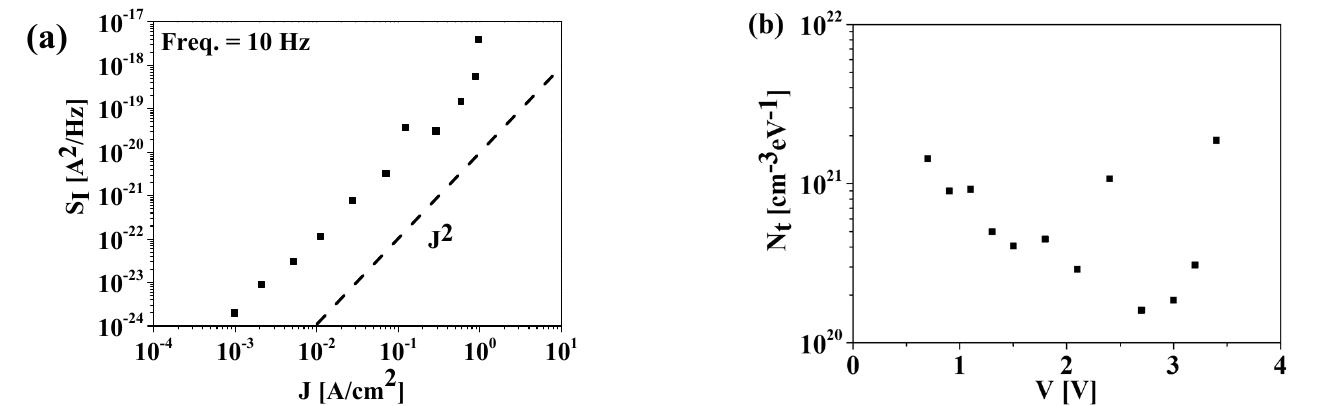
Figure 5. ( a ) S I / I 2 versus J and ( b ) E × S I / I 2 versus J at f = 10 Hz.